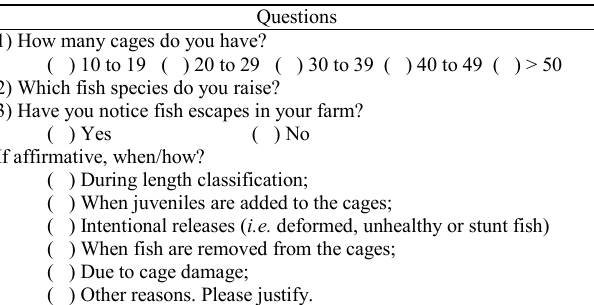
Table 1. Questionnaire applied to producers working with cage aquaculture in Furnas Reservoir, Minas Gerais,